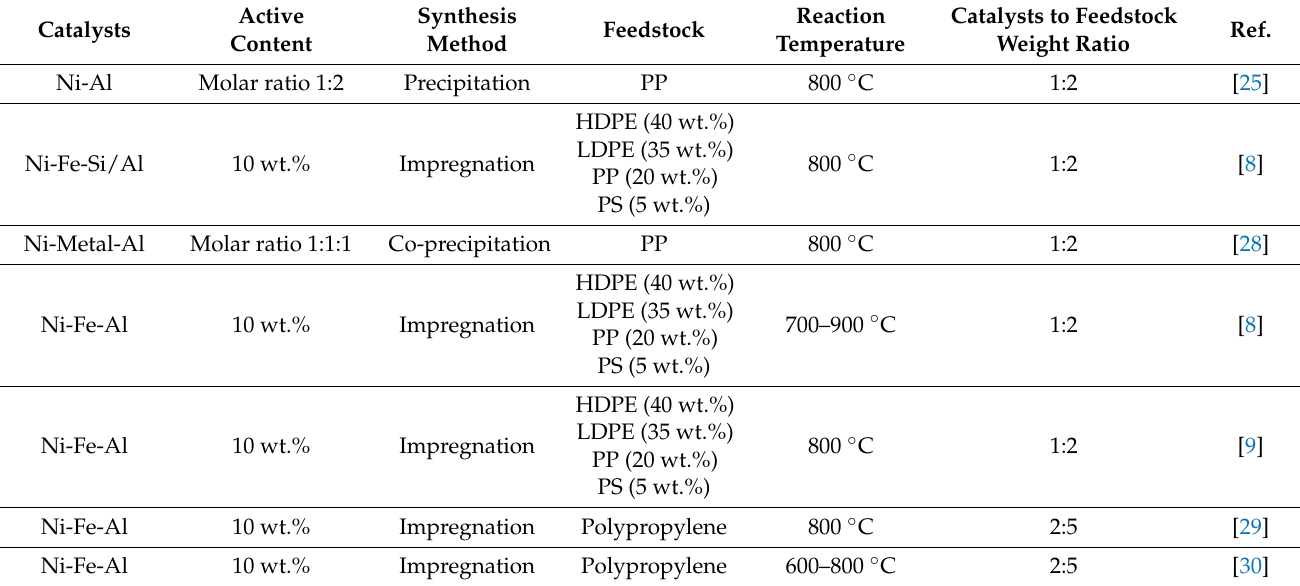
Table 1. Summary of different catalysts in the production of carbon nanotube composites (CNCs) from waste plastic.